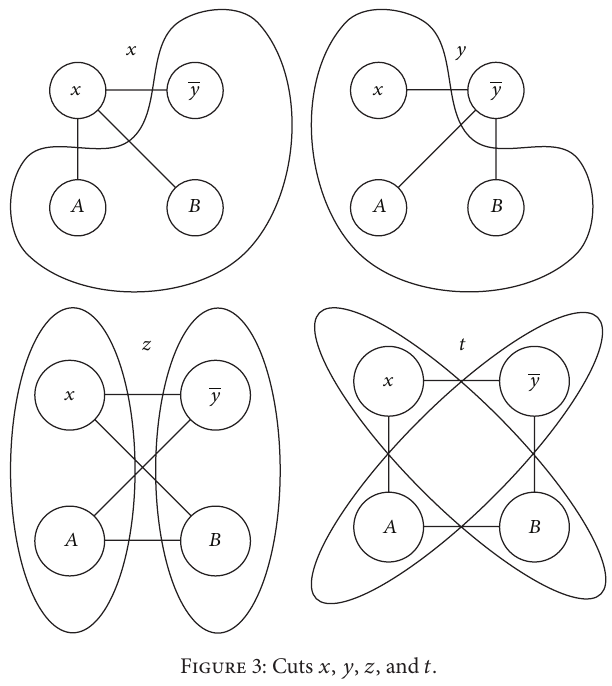
Figure 3: Cuts 𝑥 , 𝑦 , 𝑧 , and 𝑡